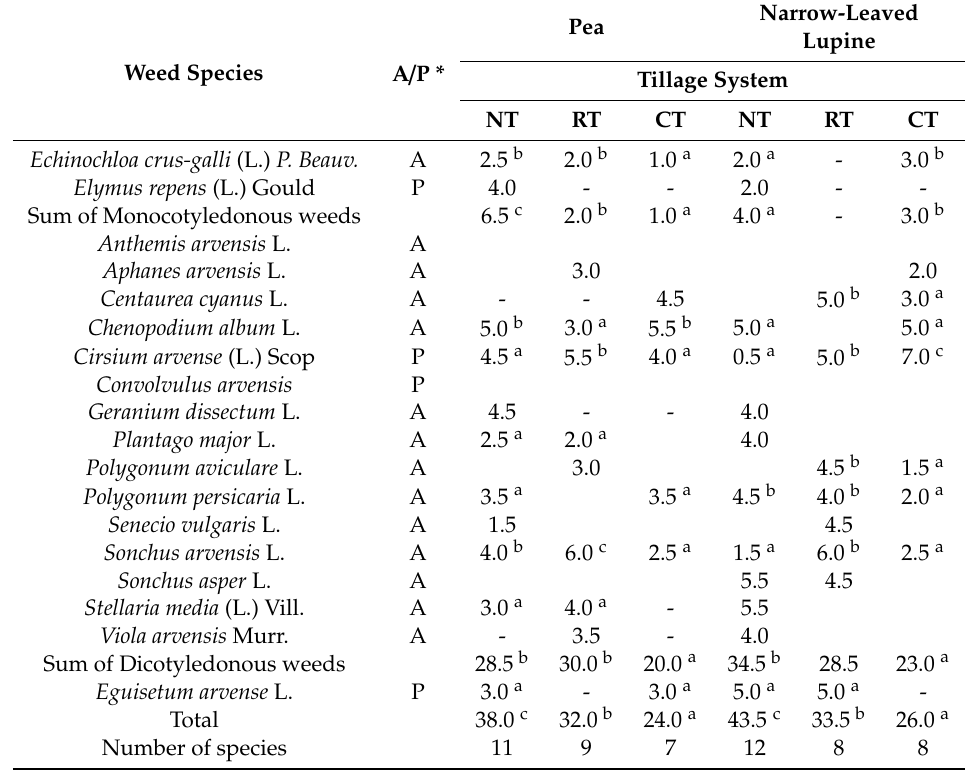
Table 4. Weed species composition in pea and lupine crop depending on tillage systems in flowering stage (plants · m − 2 ) (average for the years of